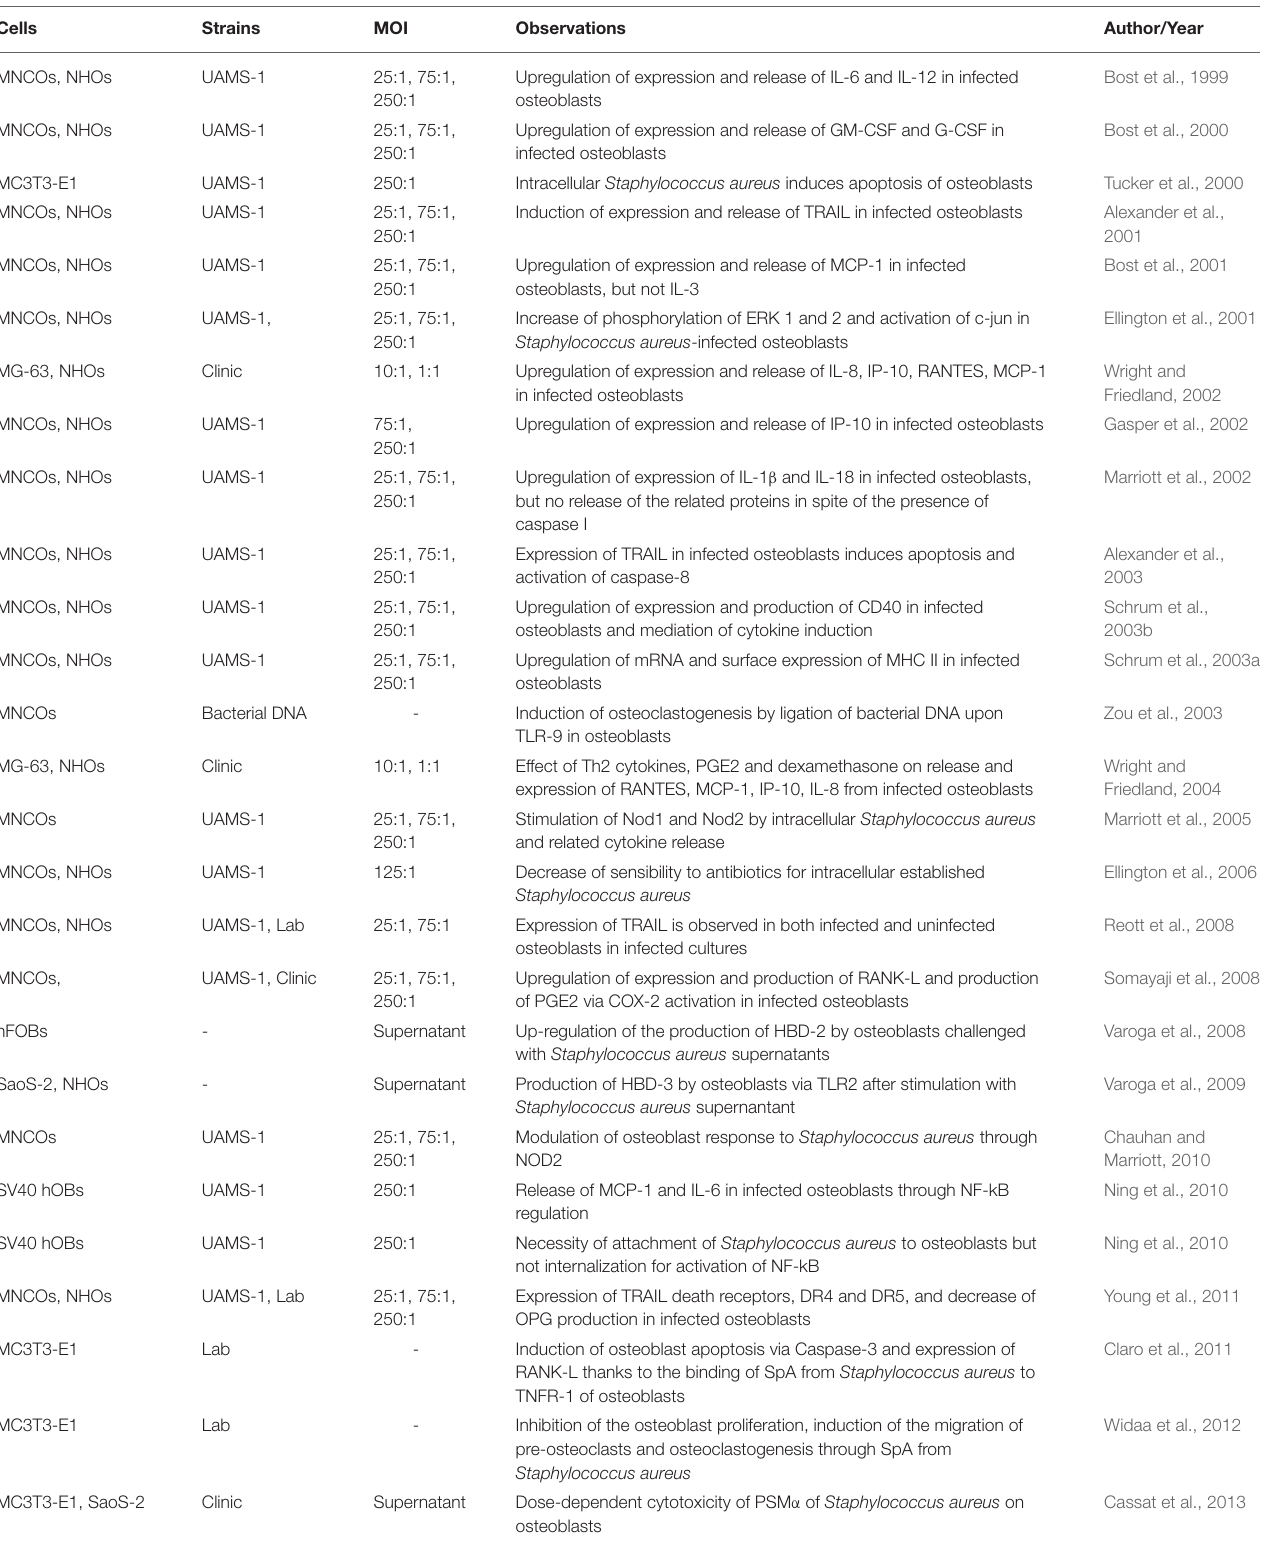
TABLE 2 | In vitro consequences of Staphylococcus aureus /osteoblast interaction. Cells Strains MOI